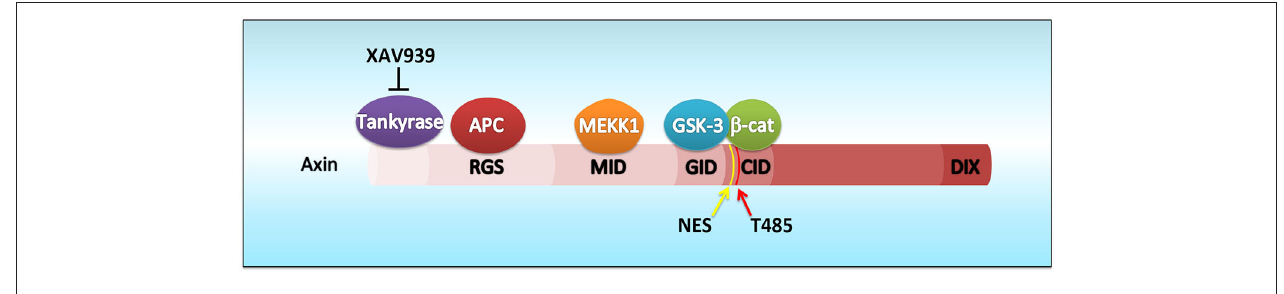
and β -catenin (CID). A small molecule, XAV939, stabilizes Axin by inhibiting the poly-ADP-ribosylating enzyme tankyrase which stimulates Axin degradation through the ubiquitin-proteasome pathway. It is worth noting that the Cdk5-dependent phosphorylation site (Thr485) is located close to the nuclear export signal (NES) of Axin (amino acids